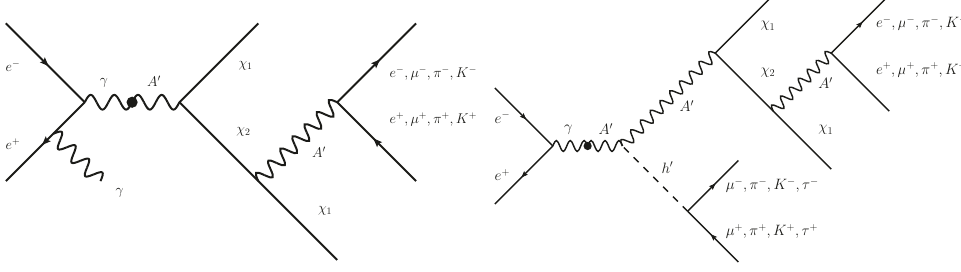
Figure 1 . Feynman diagrams depicting the leading search channels for inelastic DM: A 0 production in association with a single photon (left) and A 0 production in association with a dark Higgs h 0 (right) with subsequent decays into both visible and dark sector